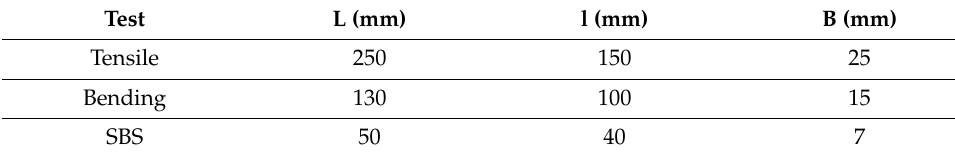
Figure 4. Geometry of mechanical-test specimens. Table 2. Dimensions of test specimens for mechanical tests.